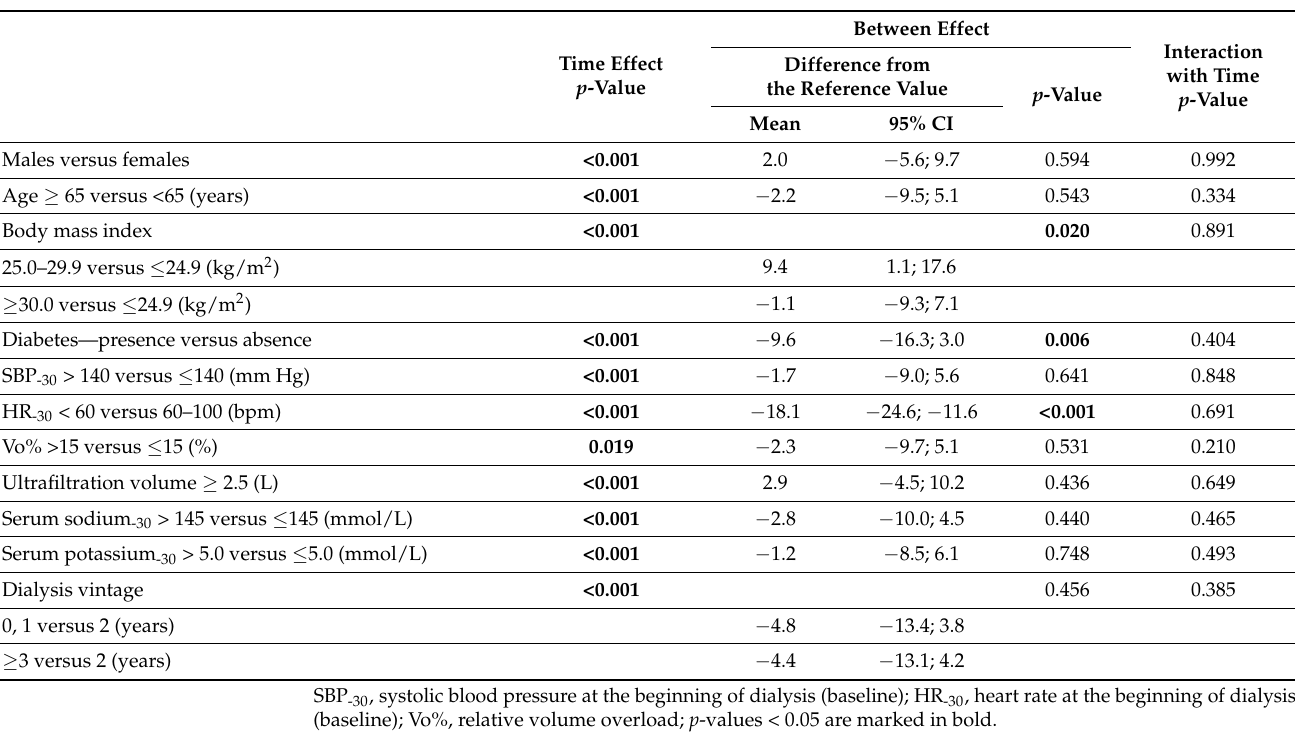
Table 5. Dynamics of heart rate during hemodialysis in relation to selected clinical and dialysis parameters.